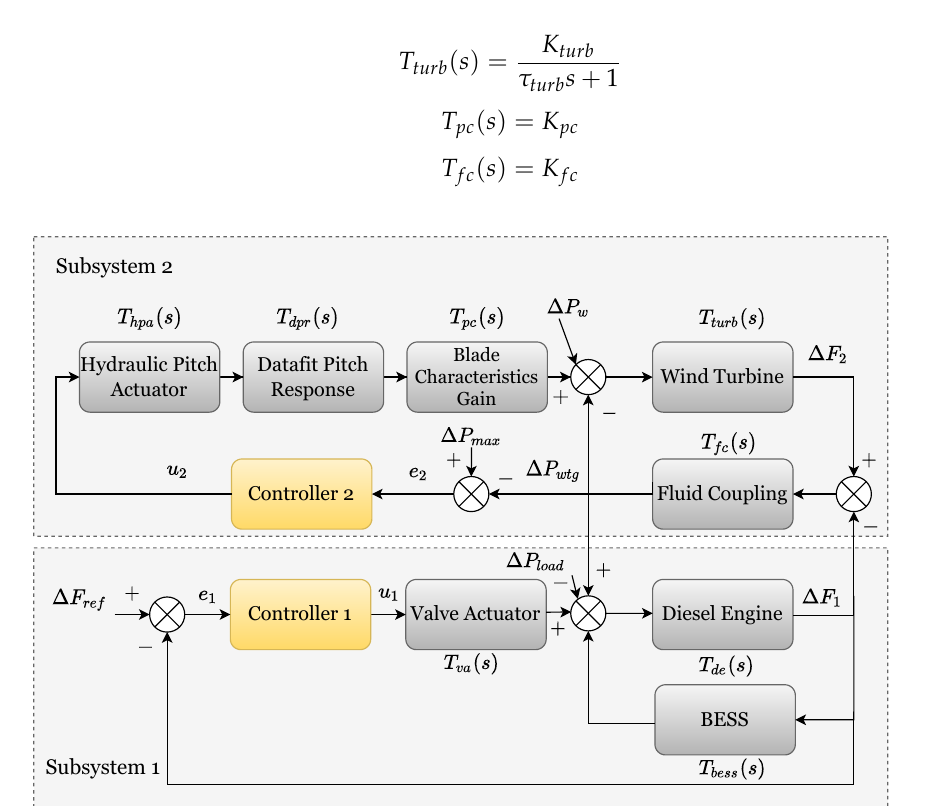
Figure 2. Block diagram of the mechanically coupled wind–diesel